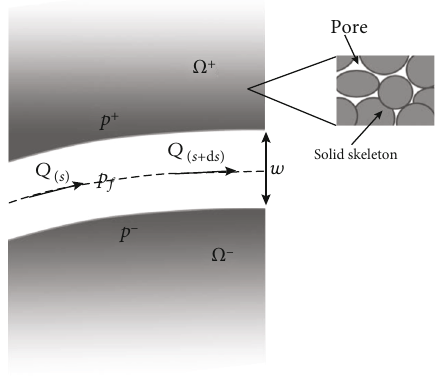
Figure 10: Physical model of fl uid fracturing in coals.